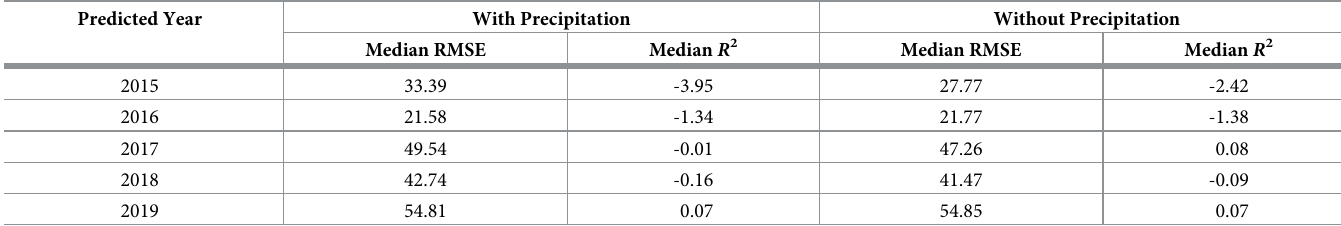
Table 3. Prediction errors splitting by year and using Random